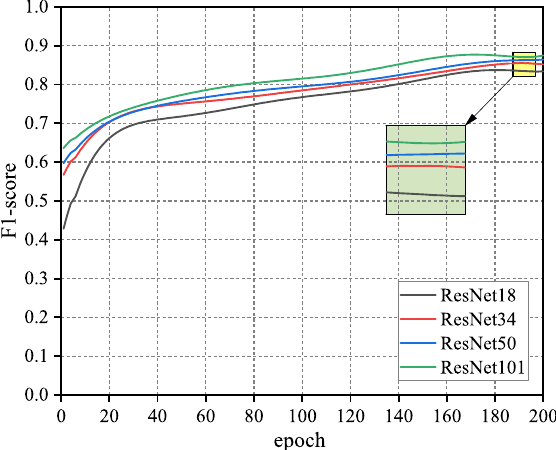
Figure 5. Progression of F1-score values for four ResNet series models as the backbone of the encoder during training. The ResNet models are with 18 layers (ResNet18), 34 layers (ResNet34), 50 layers (ResNet50) and 101 layers